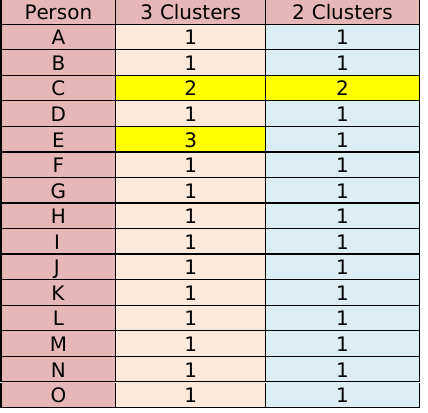
Table 2. “Cluster Analysis for Sub Criteria – Ease of